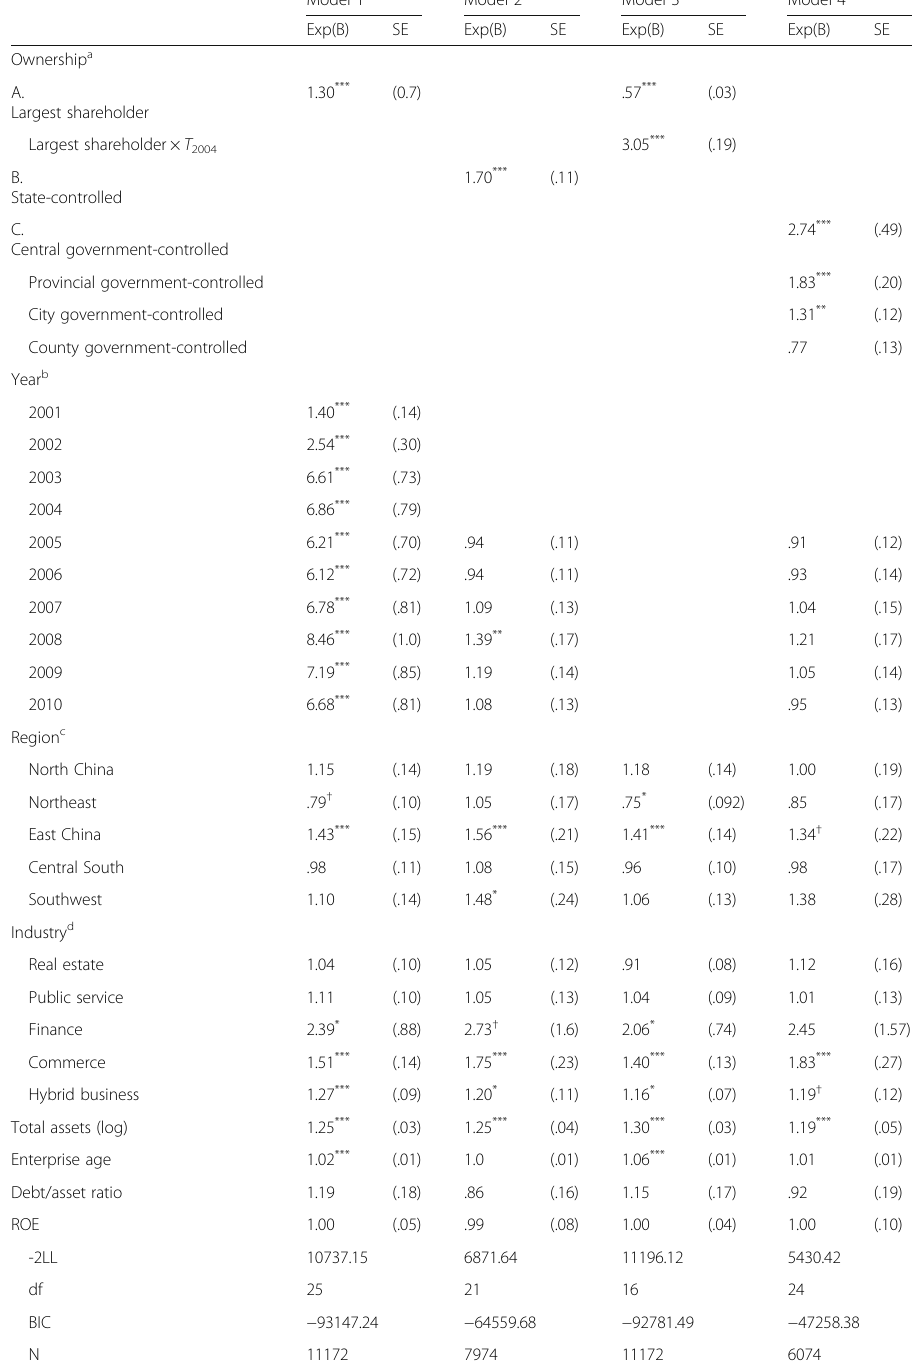
Table 2 State ownership and interlocking directorate relations: 2000 – 2010, bootstrap